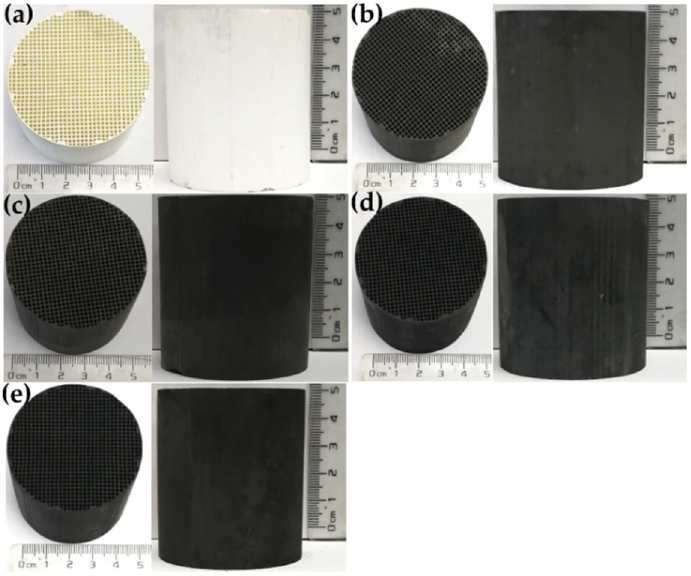
Figure 3. The photographs of as-prepared monolith catalysts. Blank honeycomb ceramics monolith ( a ), MnCo 2 O 4 -HC ( b ), Mn 0.9 K 0.1 Co 2 O 4 -HC ( c ), Mn 0.8 K 0.2 Co 2 O 4 -HC ( d ), Mn 0.7 K 0.3 Co 2 O 4 -HC ( e ).